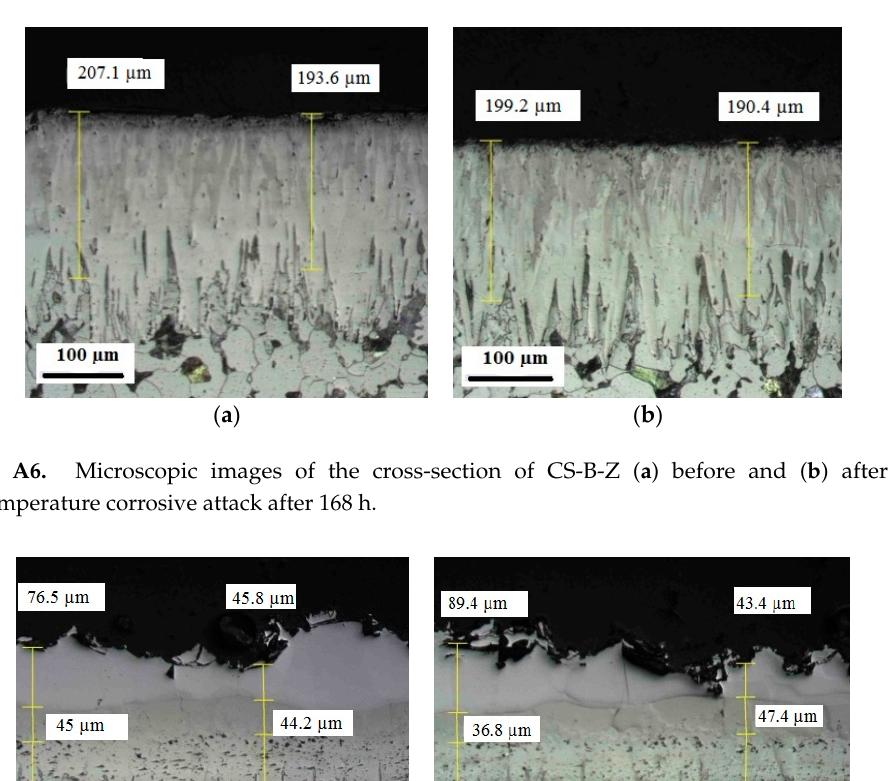
Figure A5. Microscopic images of the cross-section of CS-B-BN ( a ) before and ( b ) after the low-temperature corrosive attack after 168 h.